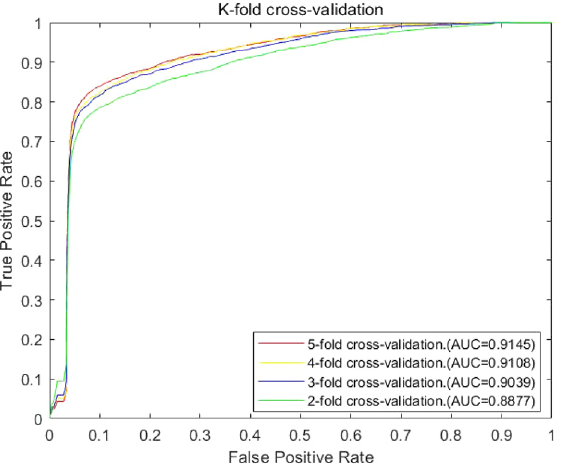
Figure 2. Influence of parameter variation on model prediction accuracy. The figure shows the ROC curve of k (where k = 2, 3, 4, 5) fold CV and the respective AUC values (fivefold CV: AUC = 0.9145; fourfold CV: AUC = 0.9108; threefold CV: AUC = 0.9039; twofold CV: AUC = 0.8877).